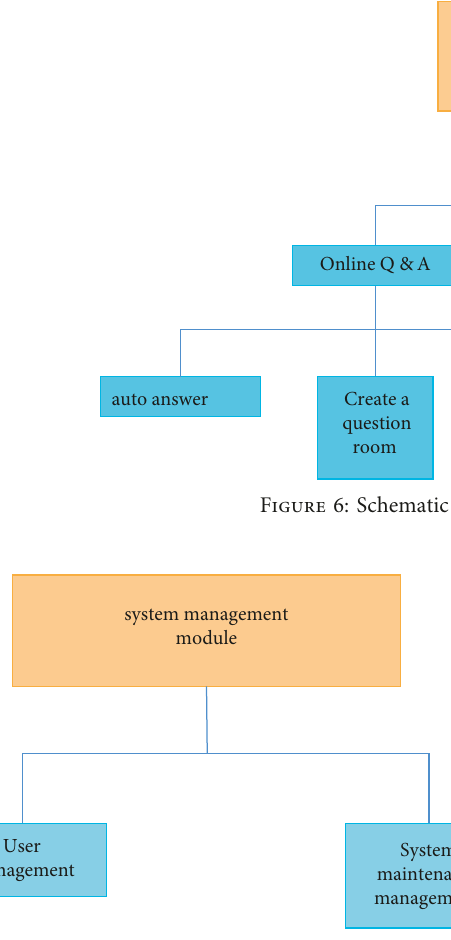
Figure 7: Function module diagram of background management module. Table 1: Comparison of storage cost between PKE+ PEKS scheme and traditional scheme in this study.